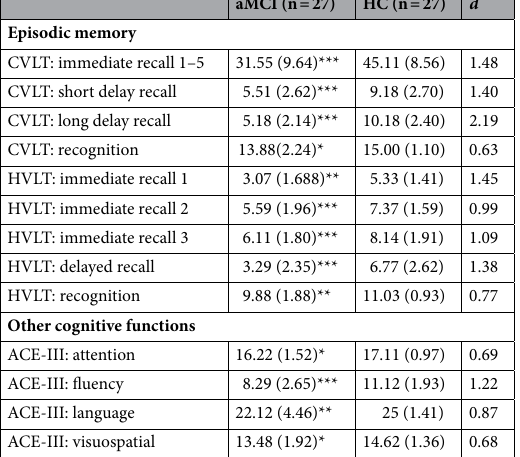
aMCI (n = 27) HC (n = 27)